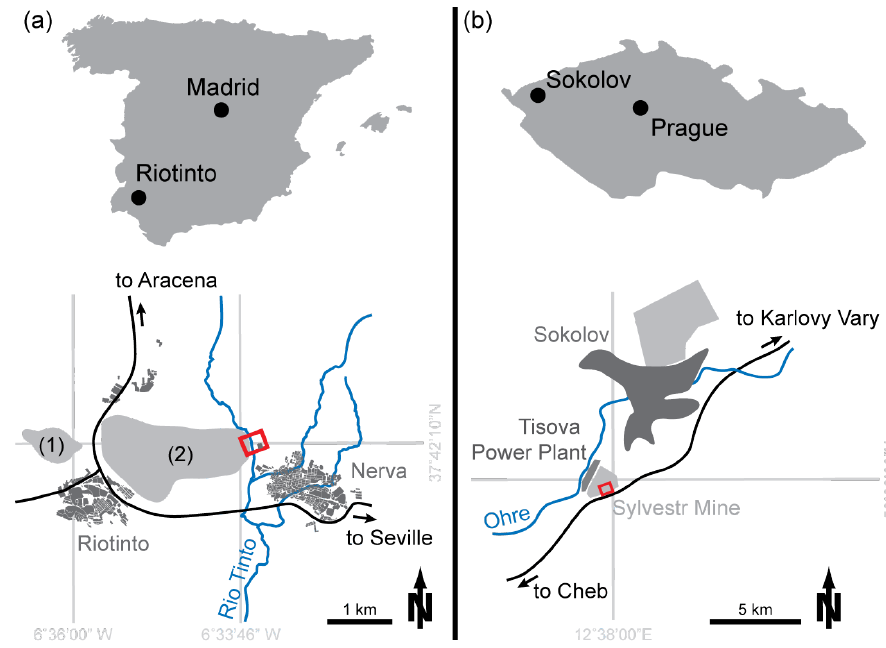
Figure 1. ( a ) Location of the first test site within Spain and the Riotinto mining area, with the open pit mines Corta Atalaya (1) and Cerro Colorado (2); ( b ) location of the second test site within the Czech Republic and the Sokolov